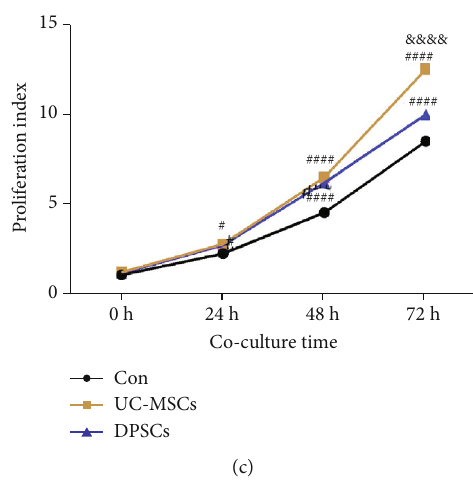
Figure 1: MSCs promote the viability and proliferation of BEAS-2B cells. (a) Cell viability was measured by CCK8 assays at 24h, 48h, and 72h. N = 4 . (b) Flow cytometric analysis of BEAS-2B proliferation after culture with fresh medium (top) or the supernatant of UC-MSCs (middle) or DPSCs (bottom) and the fl uorescence intensity of Dye 670 at 0h, 24 h, 48 h, and 72h after staining. (c) Statistical analysis of the control and MSCs groups. N = 3 . # P < 0 : 01 and #### P < 0 : 0001 vs. Con; & P < 0 : 05 , &&& P < 0 : 001 , and &&&& P < 0 : 0001 vs. the DPSCs group. Data are shown as the means ± SEM , and comparisons between groups were measured by ANOVA followed by Tukey ’ s multiple comparisons test. Con: control; UC-MSCs: umbilical cord mesenchymal stem cells; DPSCs: dental pulp mesenchymal stem